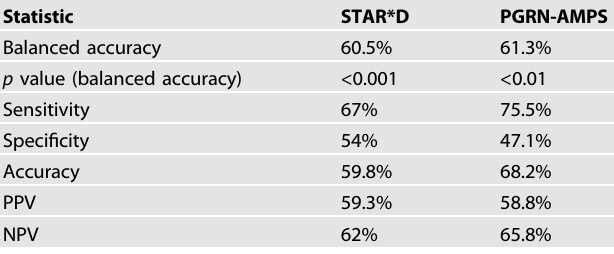
Fig. 3 Algorithm ’ s average balanced accuracy across medications. Bootstrap histogram depicting the results of 100,000 bootstrap runs on the fi nal test set, which generated the bootstrap distribution of balanced accuracies across medications, along with its 95% con fi dence interval (purple area). The distribution is compared with chance (dashed vertical line) and the observed average balanced accuracy (solid vertical line) in the fi nal test set. Table 2. Citalopram model statistics for both studies ’ fi nal test sets: statistics table describing the success of the citalopram model in predicting response and no-response for citalopram-treated participants, in STAR*D and PGRN-AMPS fi nal test datasets.